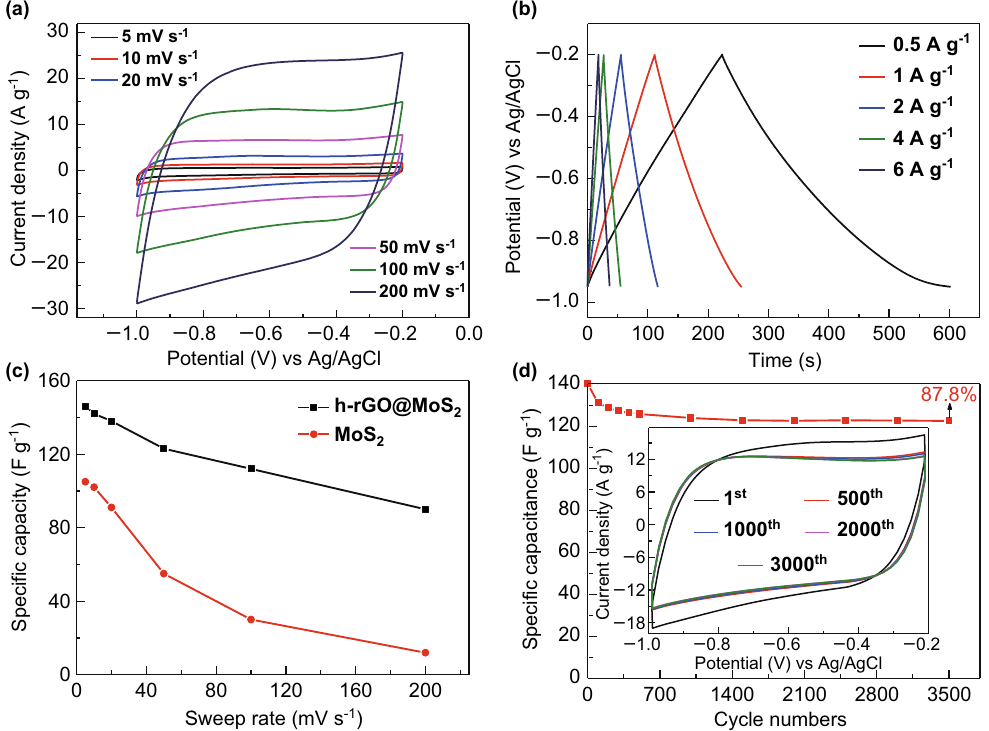
Fig. 4 a CV curves of h-rGO@MoS 2 electrode at various sweep rates (5, 10, 20, 50, 100, and 200 mV s - 1 ) in 1 M Na 2 SO 4 electrolyte. b Galvanostatic curves of h-rGO@MoS 2 at various current densities (0.5, 1, 2, 4, and 6 A g - 1 ). c Capacitance retention property of h-rGO@MoS 2 and MoS 2 at sweep rates from 5 to 200 mV s - 1 . d Cycle stability and capacitance retention of the h-rGO@MoS 2 electrode tested at a scan rate of 100 mV s - 1 ; the inset shows the CV curves for the 1st, 500th, 1000th, 2000th, and 3000th